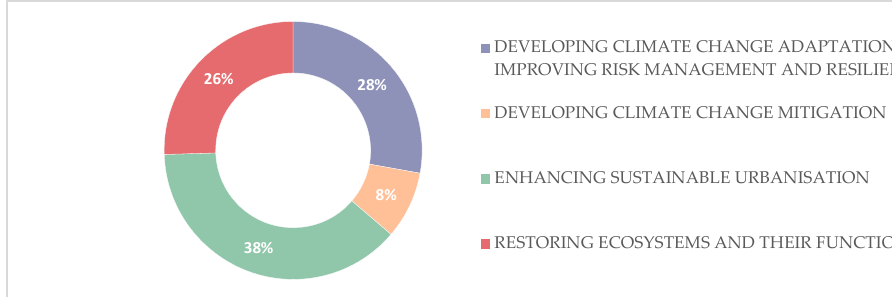
Figure 6. Distribution of the multiple benefits of NbS.